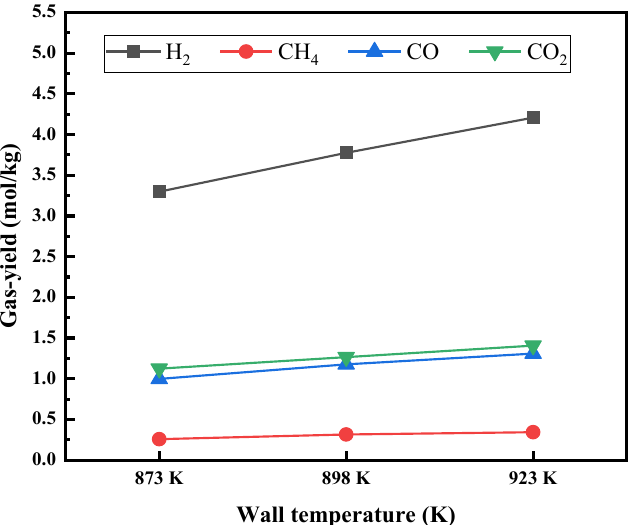
Figure 21. Axial temperature distribution of fluidized bed under different wall temperatures.